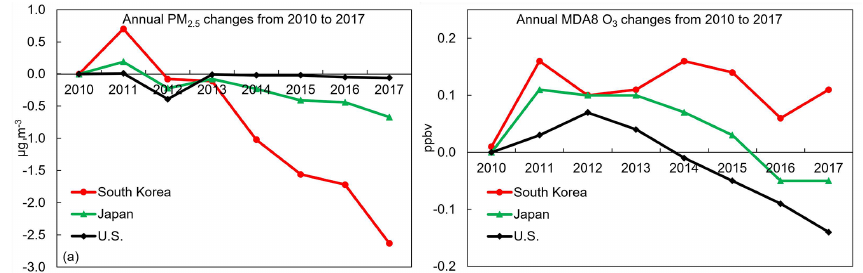
Figure 6. The annual population-weighted PM 2 . 5 (a) and MDA8 O 3 (b) changes in South Korea, Japan, and US from 2010 to 2017 caused by Chinese emission changes. Table 4. The changes for the PM 2 . 5 -mortality burden under the emission changes in China from 2010 to 2017 in China, as well as three other downwind regions – South Korea, Japan, and US. The mortality burden changes at global level are also included. Positive values mean emission change in China increases the PM 2 . 5 -related mortality burden in this region, and negative values mean decreases in the PM 2 . 5 -related mortality burden. Year China South Korea Japan US Global %